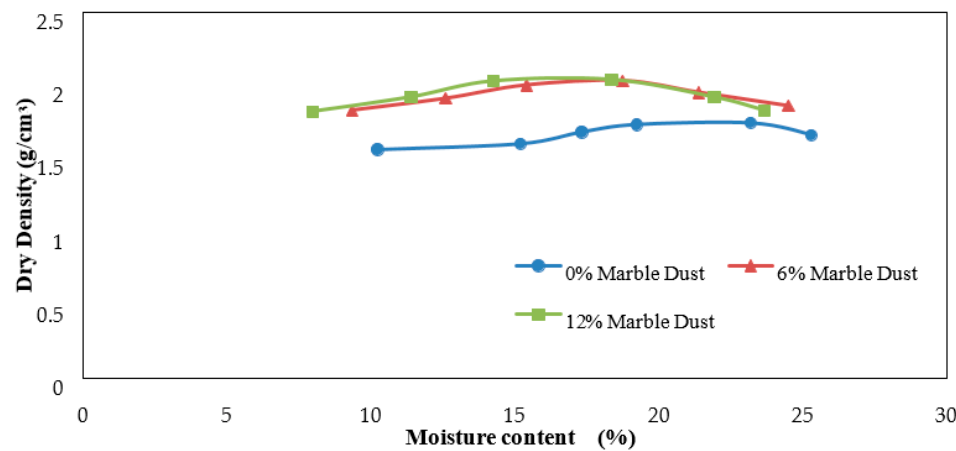
Figure 9. Saw dust Proctor results.